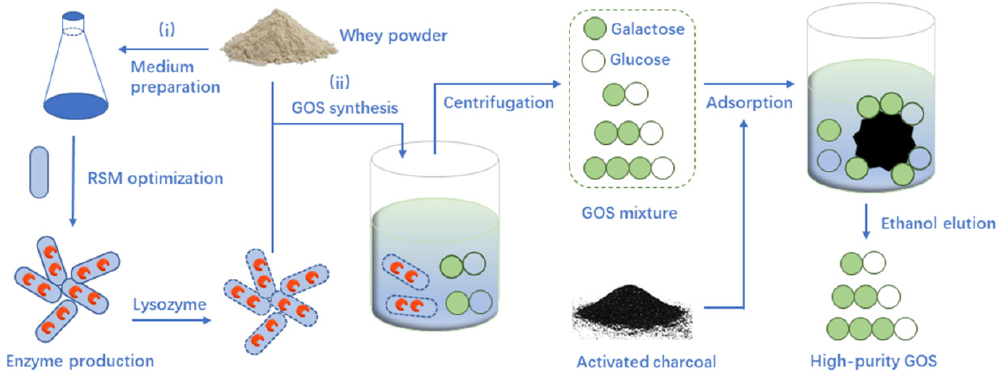
Figure 1. Outline of the integrated utilization of dairy whey in the β -galactosidase production and GOS synthesis followed by purification.